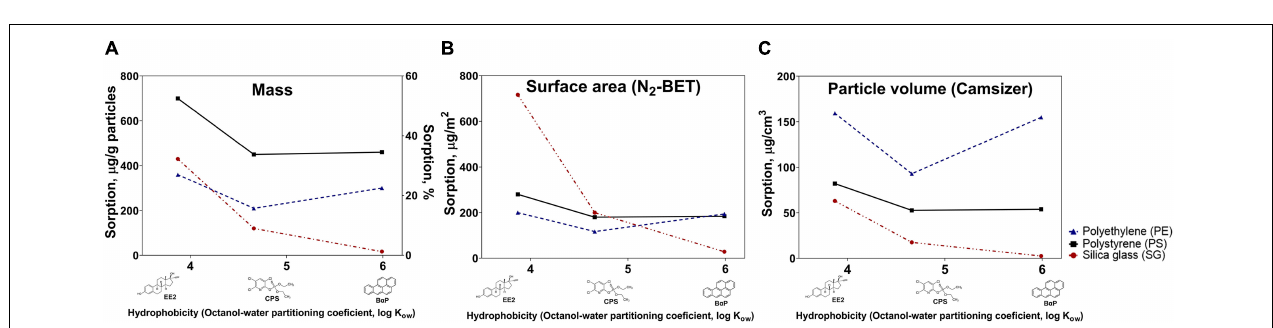
FIGURE 1 | Morphometric characterization of experimental microparticles (PS, PE, and SG): particle morphology and surface topography (A–C) and particle size distribution, sphericity and symmetry (D) . Specific N 2 -BET surface area and particle volume is complementarily provided (C) .